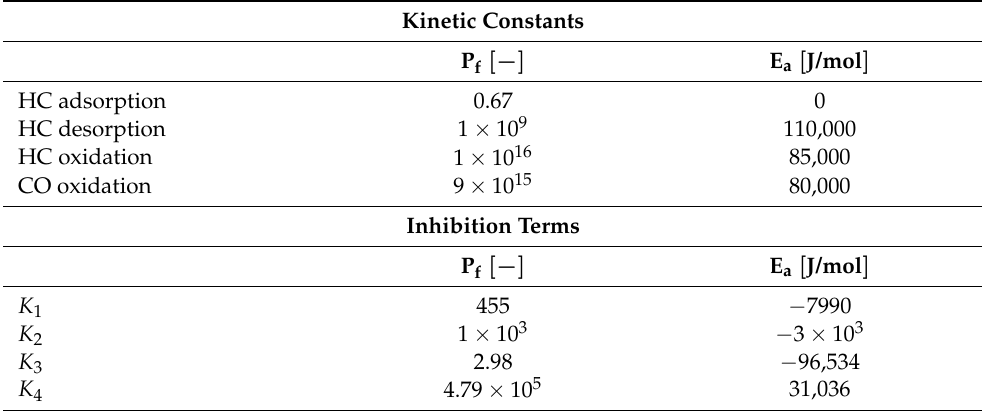
Table 4. Calibration of the reaction rate